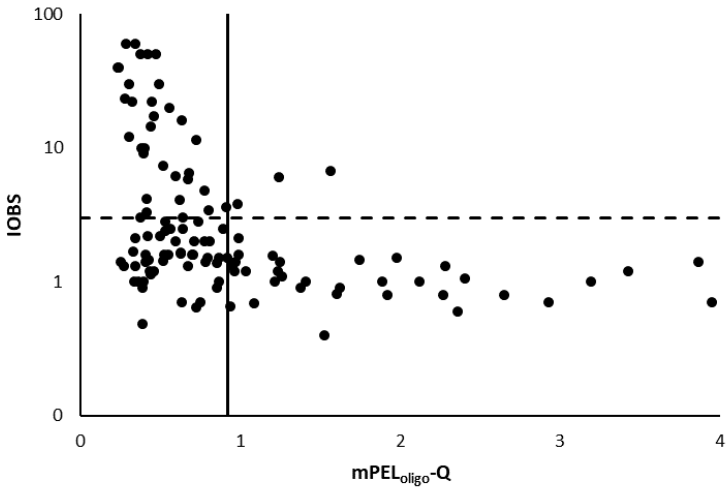
Figure 2. Relationships between the metal contamination mPEL oligo -Q index and the Oligochaete index of sediment bioindication (IOBS). Dotted horizontal line is set at the threshold for good biological quality (IOBS = 3). The vertical line is set at the mPEL-Q oligo = 0.92.